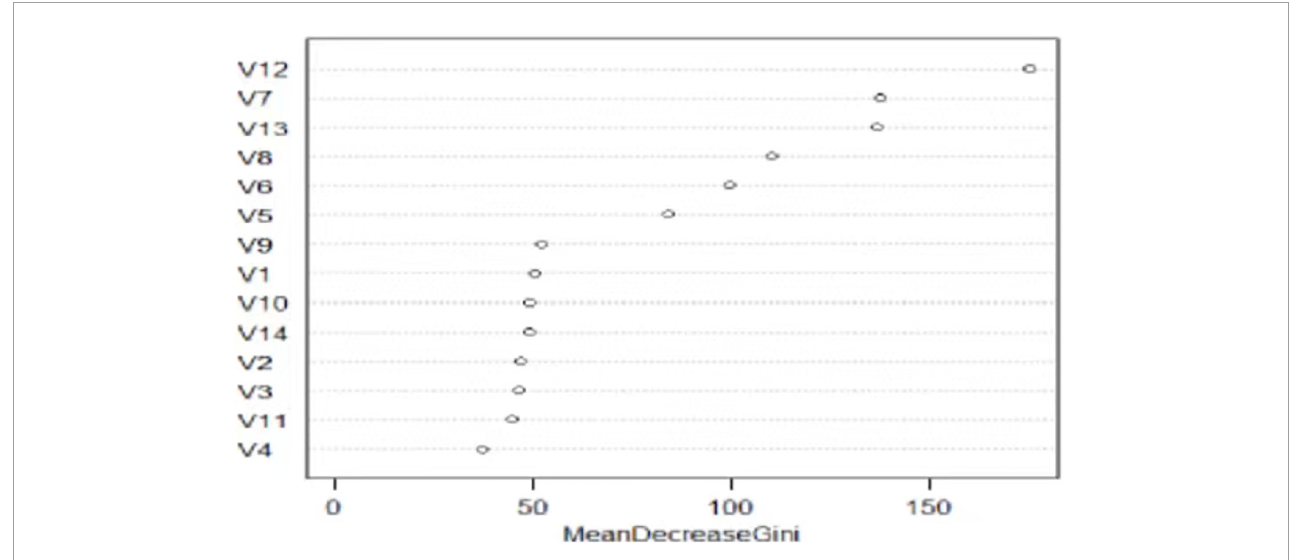
FIGURE1 Ranking of the importance of different factors on anxiety among the